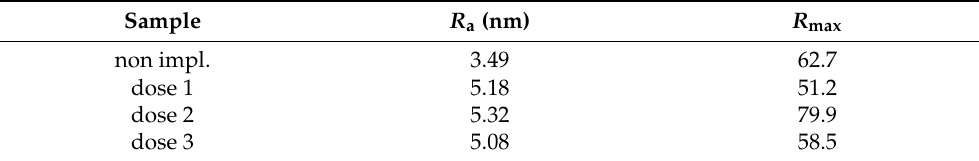
Figure 10 . Atomic force microscopy 3D topographic maps for samples ( a ) non-implanted, ( b ) dose 1, ( c ) dose 2, and ( d ) dose 3. Table 2. Roughness of Cu 2 O thin films measured with atomic force microscopy.